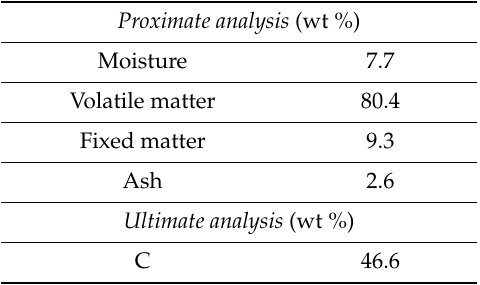
Table 1. Proximate and ultimate characterization of the herbal medicine